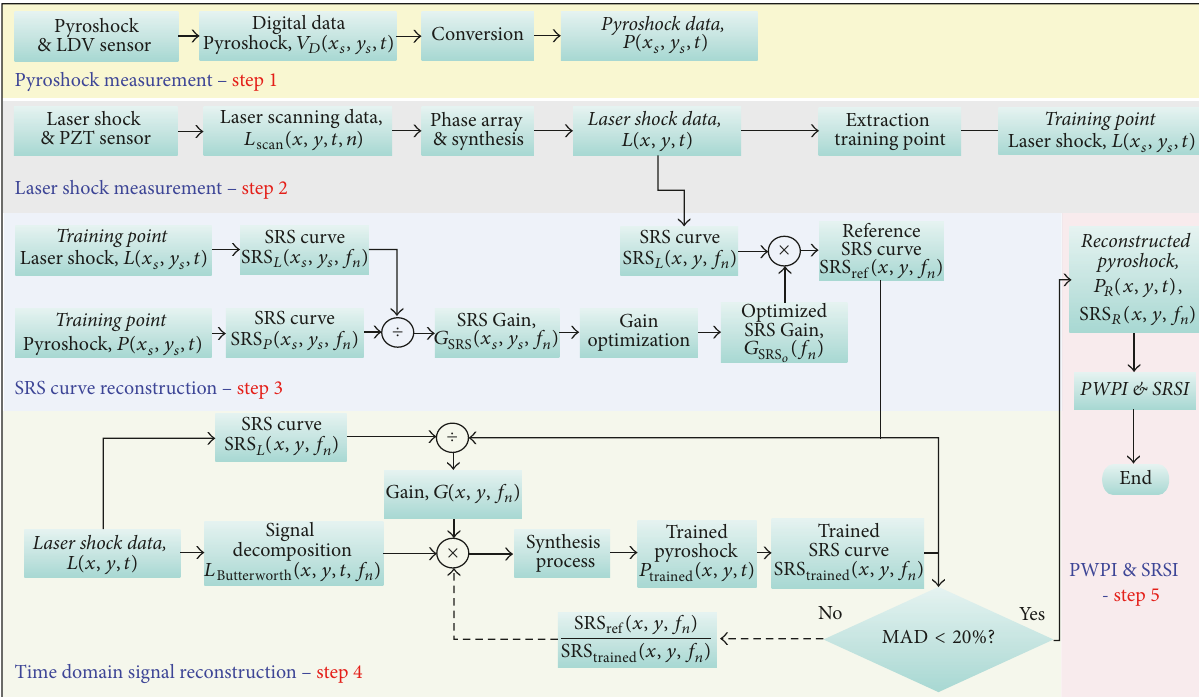
Figure 1: Flow chart of pyroshock reconstruction algorithm based on laser shock.